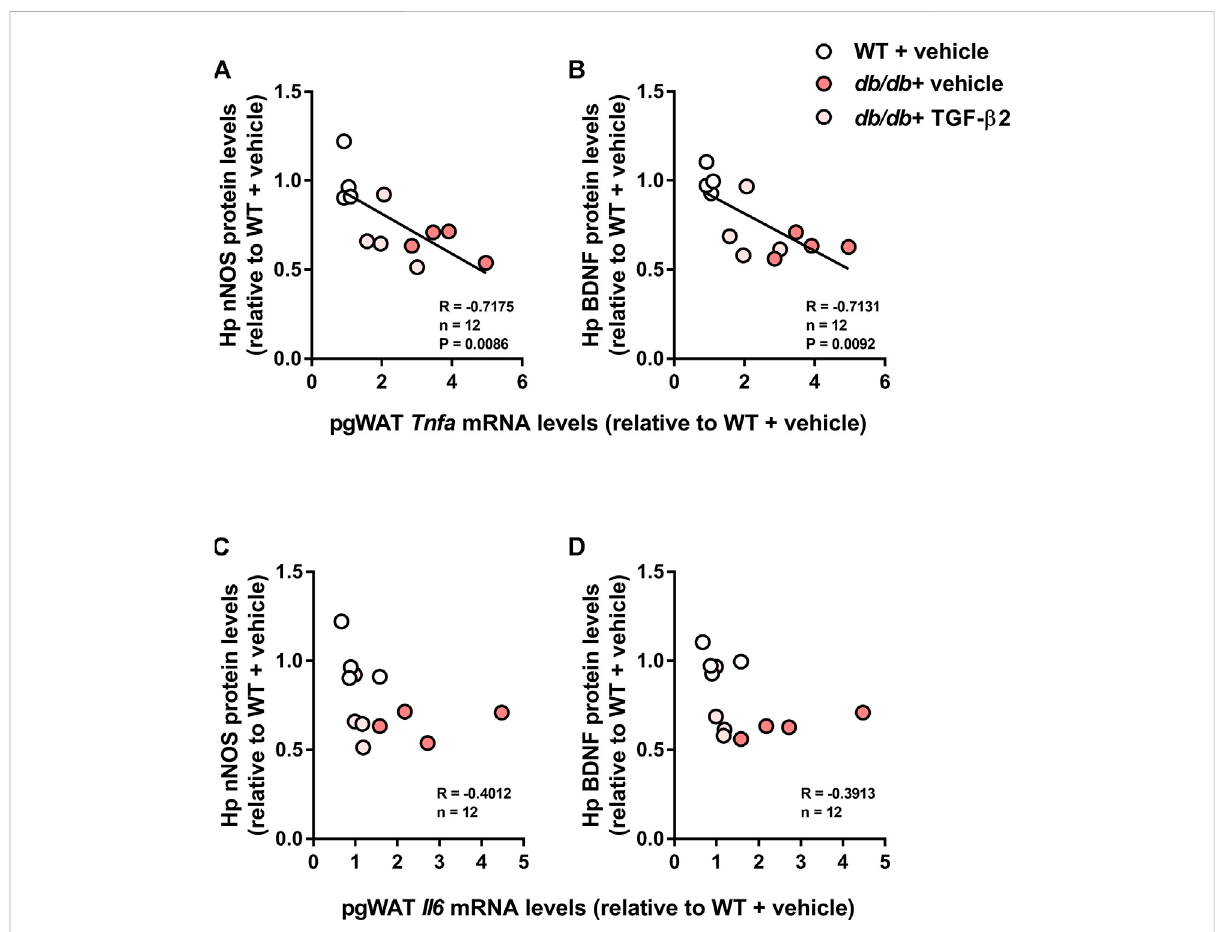
FIGURE 5 Hippocampal BDNF and nNOS protein levels correlate with pgWAT Tnfa mRNA expression, but not Il6 mRNA expression, in WT, db/db , and TGF- β 2 infused db/db mice. Correlations of pgWAT Tnfa mRNA expression with (A) hippocampal nNOS and (B) BDNF protein level. Correlations of pgWAT Il6 mRNA expression with (C) hippocampal nNOS and (D) BDNFprotein level in WT, db/db + vehicle, and db/db + TGF- β 2 mice. The lines on the scatter plots show signi fi cant correlations ( n =